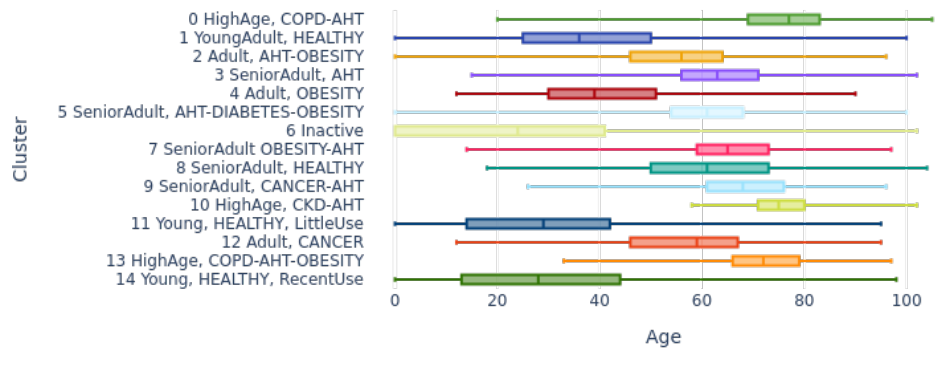
Figure 7. Distribution by age cluster (in years).